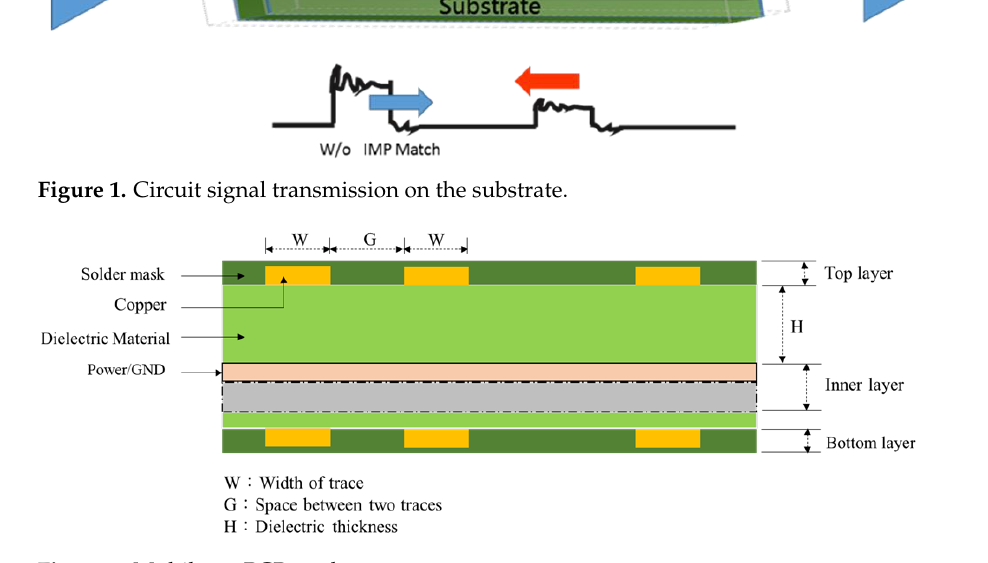
Figure 1. Circuit signal transmission on the substrate.